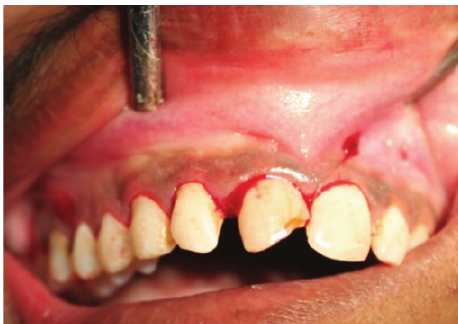
Figure 34: Surgical incision.